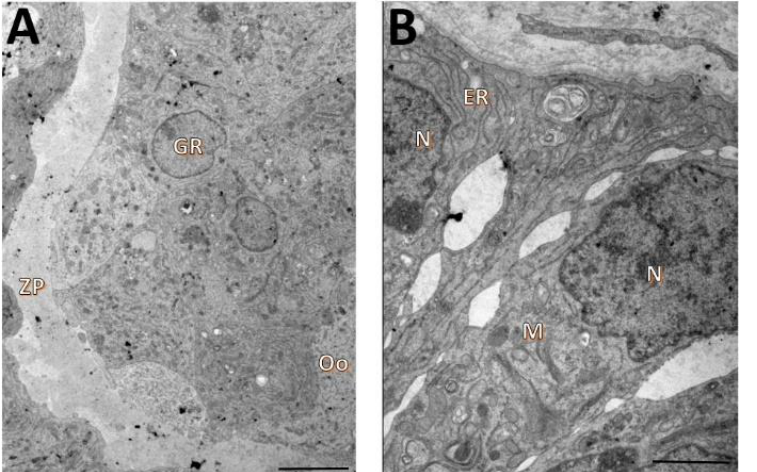
numbers of cristae (Figure 5B).